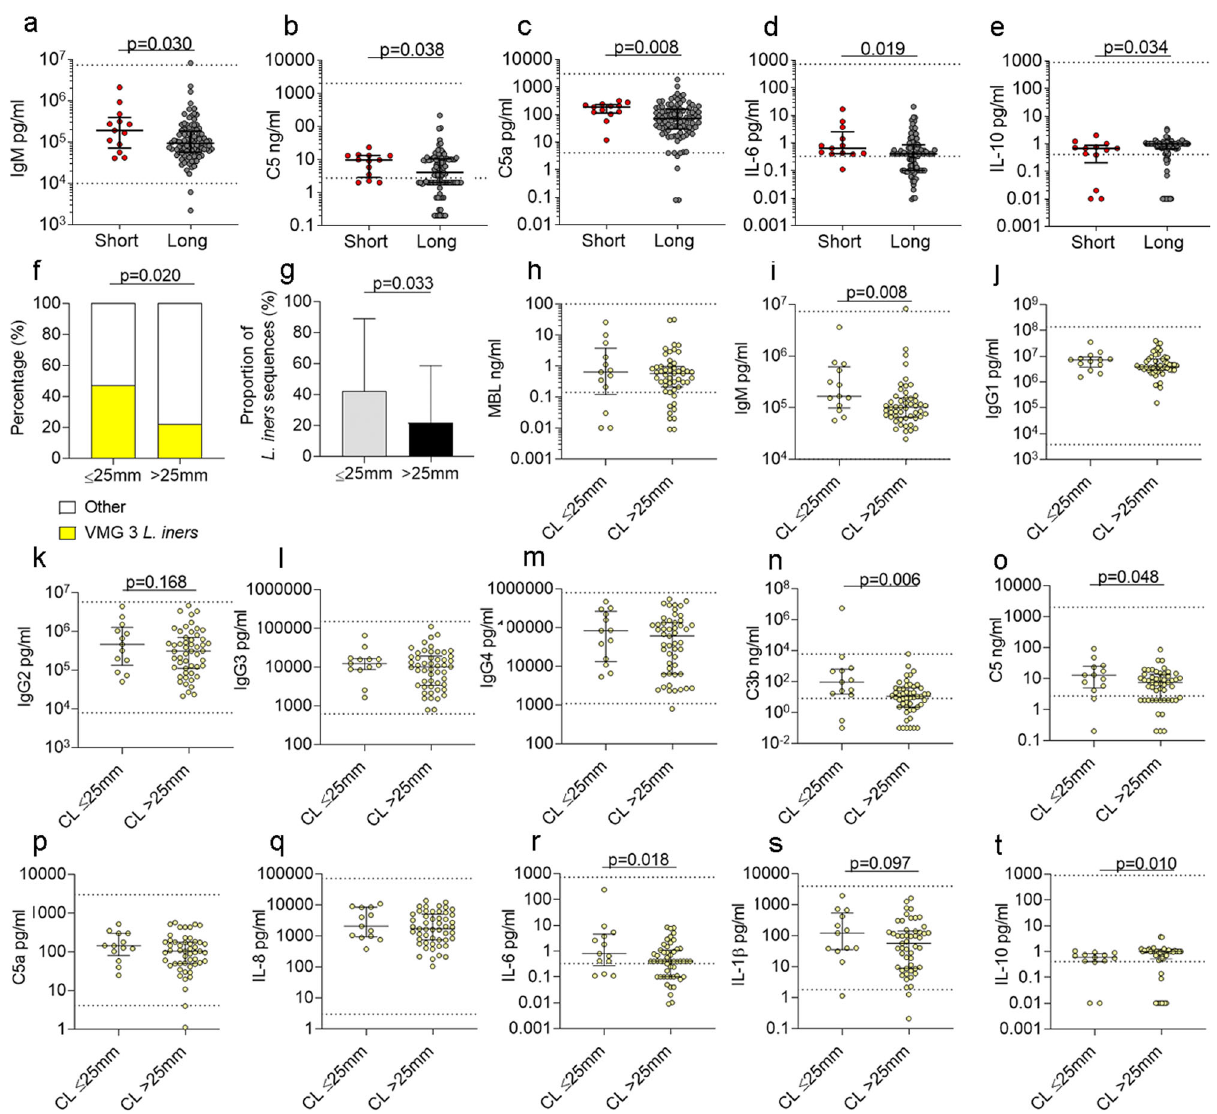
Fig. 7 Cervical shortening is associated with activation of the adaptive and innate immune response, especially in the presence of Lactobacillus iners . Cervicovaginal immune mediators were analysed in women between 12 – 16 weeks gestation prior to intervention ( a – e ). Thirteen women had a cervical length (CL) ≤ 25 mm and 96 women had a cervical length >25 mm. Median concentrations of IgM ( a ), C5 ( b ), C5a ( c ), IL-6 ( d ), and IL-10 ( e ) are presented, n = 109 women. Statistical analysis was performed using a one-sided Mann – Whitney test. The percentage of women with a short cervix ( ≤ 25 mm) or long cervix (>25 mm) with L. iners at 12 – 16 weeks is presented in f , and the proportion of L. iners sequences is presented in g , n = 111 women. Immune mediators were analysed and compared between women who had L . iners (CST III) who developed cervical shortening (CL ≤ 25 mm) and